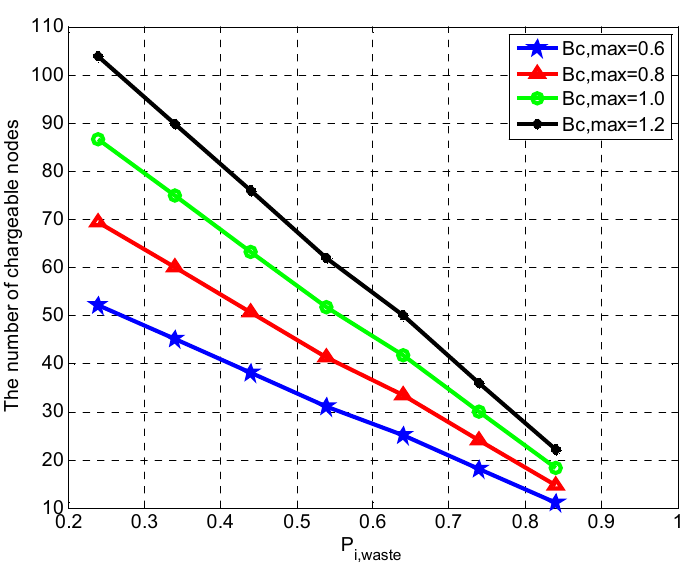
ff erent energy waste